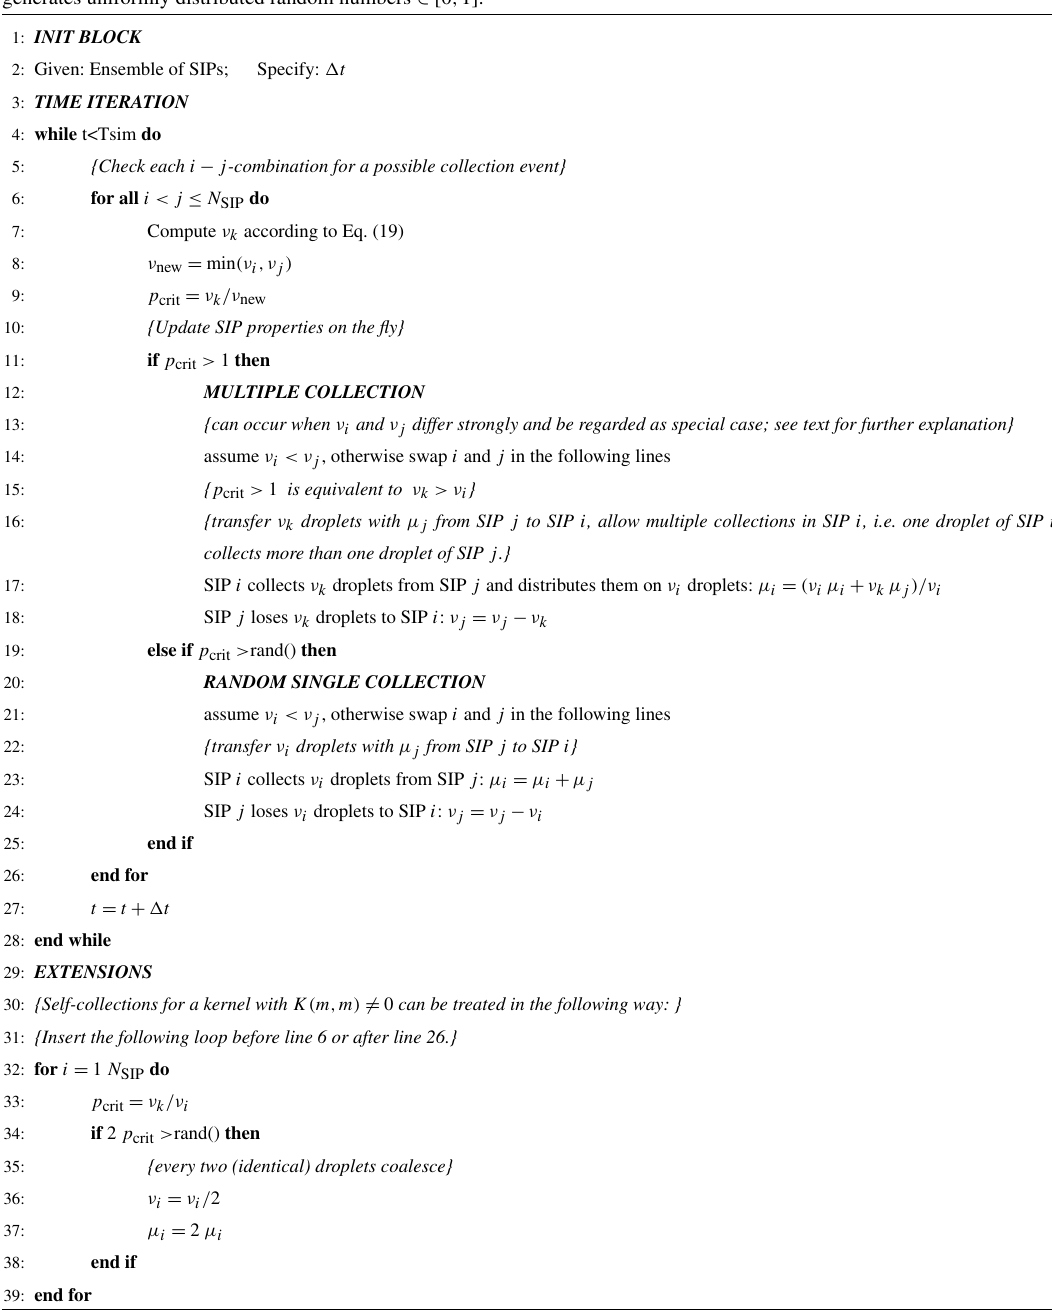
Algorithm 3 Pseudo-code of the all-or-nothing algorithm (AON); style conventions are explained at the end of Sect. 2.2; rand() generates uniformly distributed random numbers